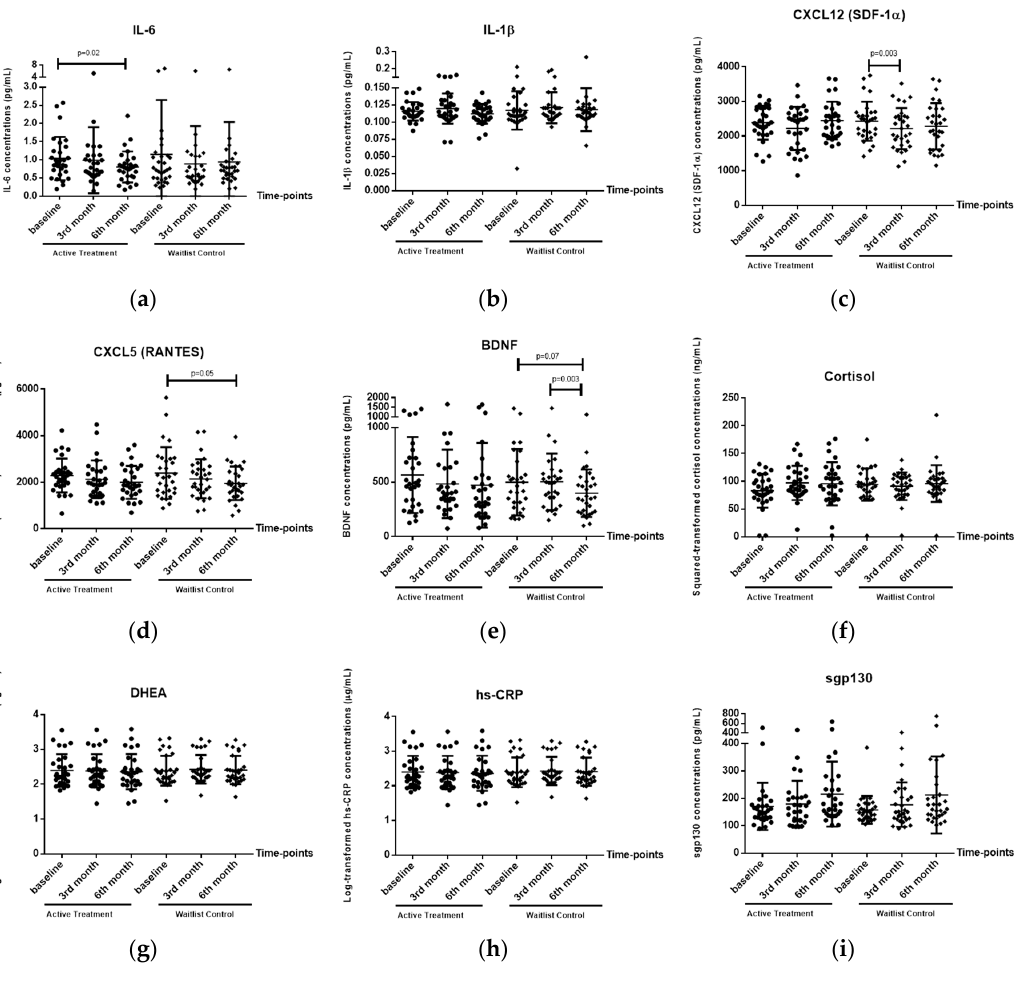
Figure 2. Changes of plasma biomarker levels in horticultural therapy (HT) and waitlist control groups. ( a ): IL-6; ( b ): IL-1 β ; ( c ): CXCL12 (SDF-1 α ); ( d ): CXCL5 (RANTES); ( e ): BDNF (brain-derived neurotrophic factor); ( f ): Cortisol; ( g ): DHEA (dehydroepiandrosterone); ( h ): hs-CRP; ( i ): Sgp-130.